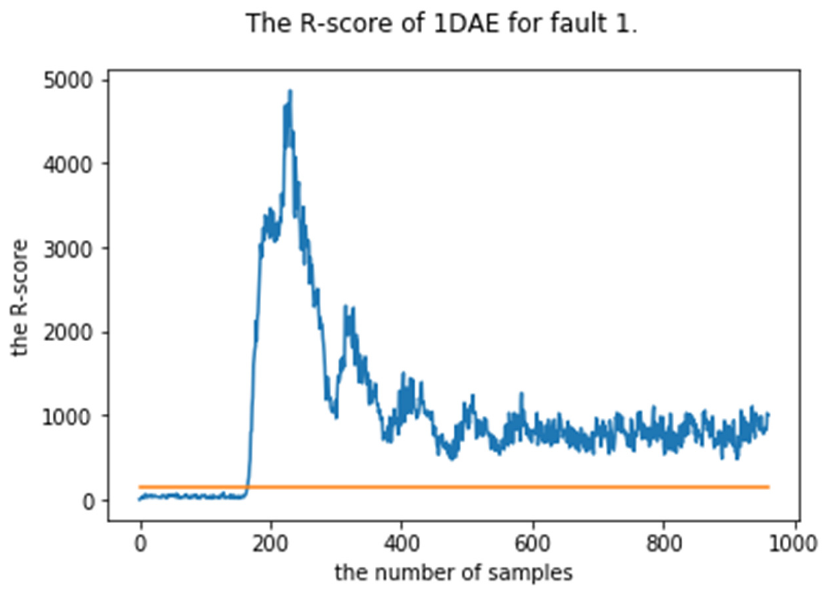
Figure 11. The R-score of the 1DAE for fault 1.